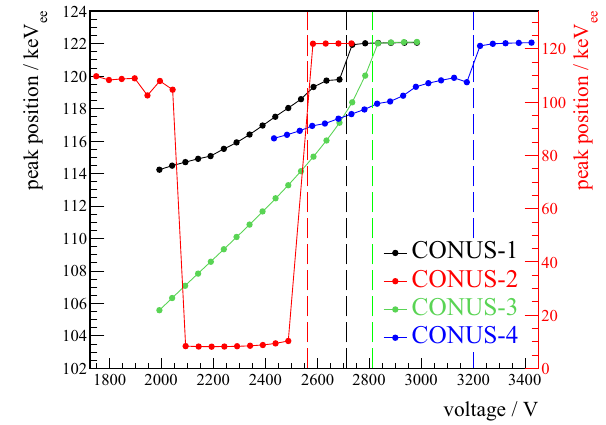
Fig. 9 Peak position of 122.1keV γ -ray line of 57 Co in dependence of the voltage applied at the HPGe diodes of C1–C4. The red y-scale refers to C2 only. The vertical lines mark the depletion voltage determined via the signal baseline